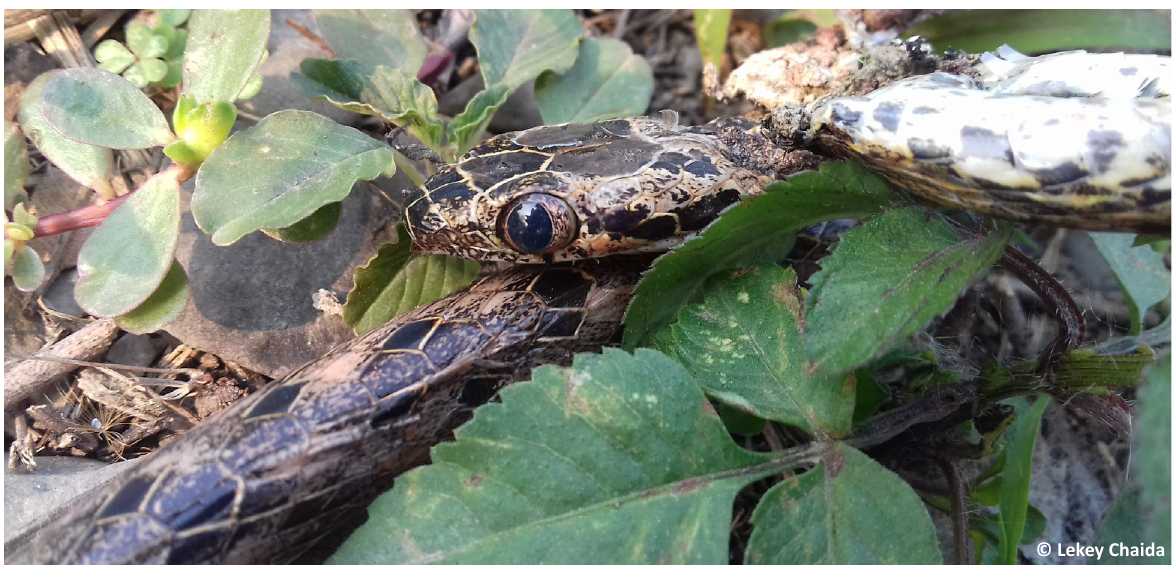
Image 1. Head of Assamese Cat Snake Boiga quincunciata.